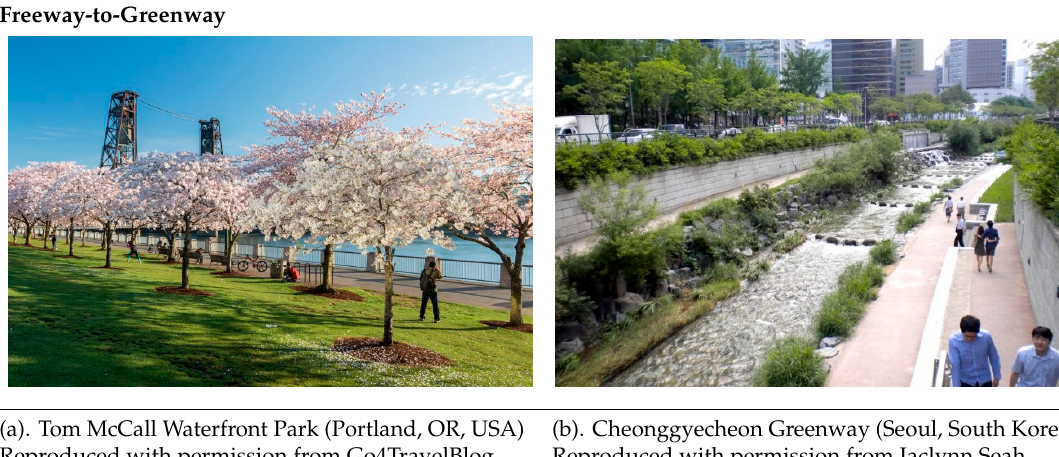
Table 7. Greenway typology: photographic examples.